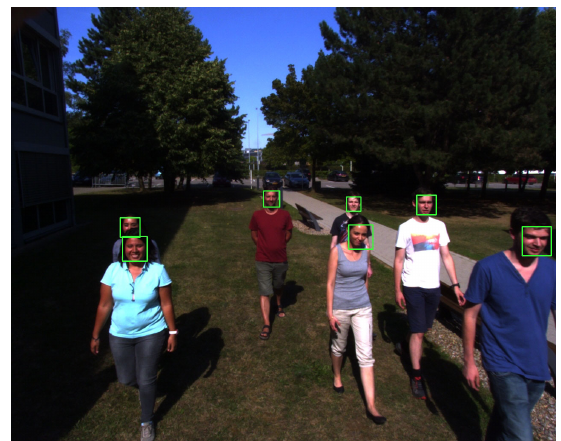
Figure 15. Fly-over